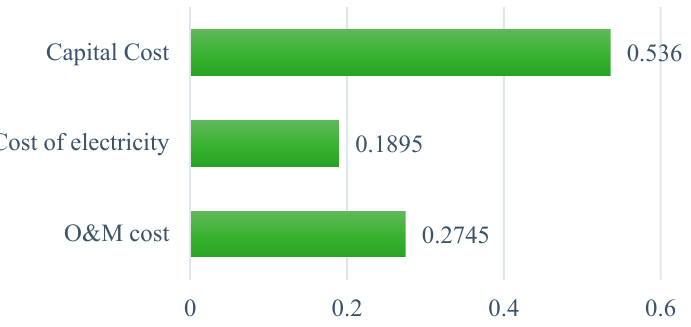
Figure 8. Priority weights of the economic sub-criteria.